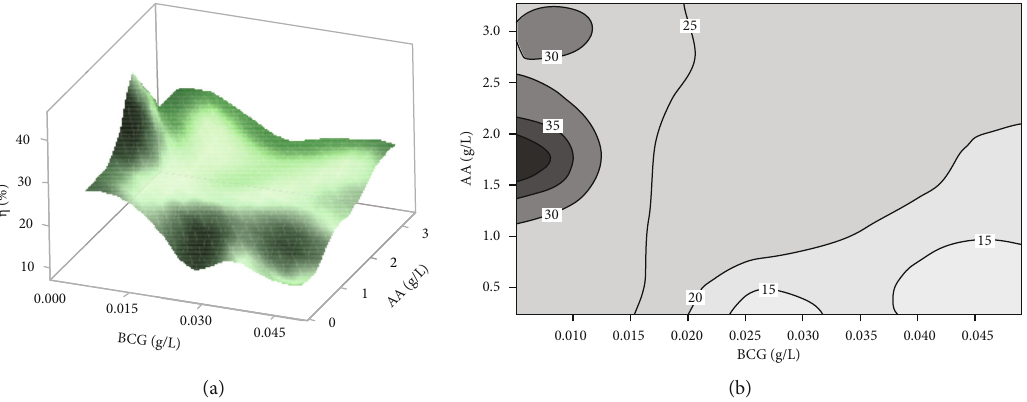
Figure 7: (a) Three-dimensional response surface displaying the e ff ects of BCG and AA on the process e ffi ciency. (b) Two-dimensional contour plot showing the e ff ects of BCG and AA on the process e ffi ciency.